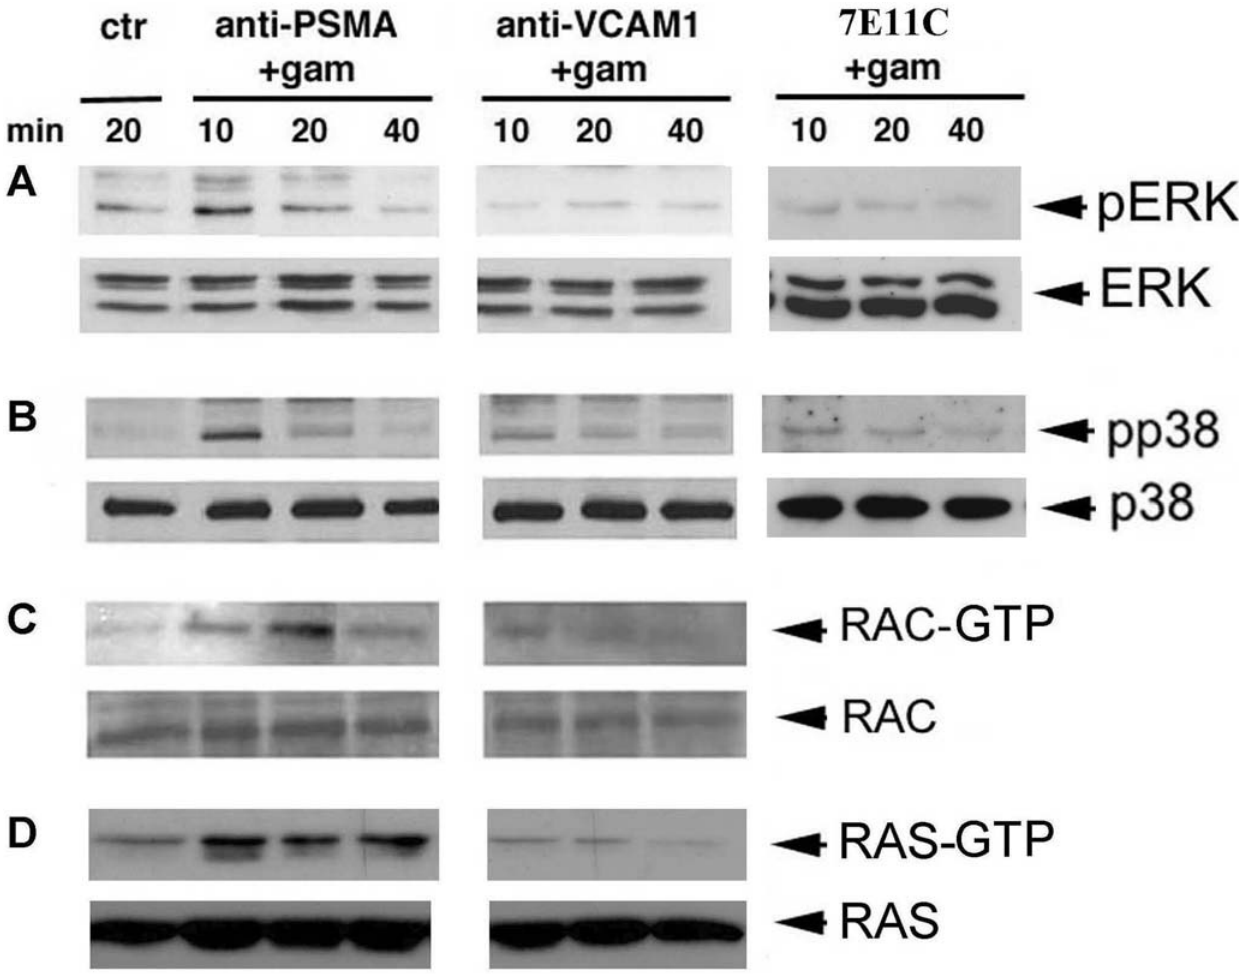
Figure 2. Kinetics of ERK1/21/2, p38, RAC 1 and RAS phosphorylation induced by PSMA cross-linking. LNCaP cells were left untreated or subjected to PSMA cross-linking for the indicated times at 37 u C. An anti-VCAM-1 mAb was used as the isotype matched control. Panels A and B: p38 and ERK1/2 activation was assessed in crude lysates. Equal amounts (20 m g) of total proteins were boiled in sample buffer and separated by SDS- PAGE. Following immunoblotting with an anti-phospho-p38 or anti-phospho-ERK1/2 mAb, immunoreactive bands were visualized by using horseradish peroxidase-conjugated secondary antibody and the ECL system. Panels C and D: RAC1 and RAS activation was evaluated by a specific assay as described in the Material and Methods section. Bound active GTP-RAC and GTP-RAS molecules were analyzed by Western blotting using an anti-RAC1 or anti-Ras mAb and visualized as above. Total amount of ERK1/2, p38, RAC1 and RAS in crude lysates are shown as loading control at the bottom of each gel. Results are representative of one of three independent